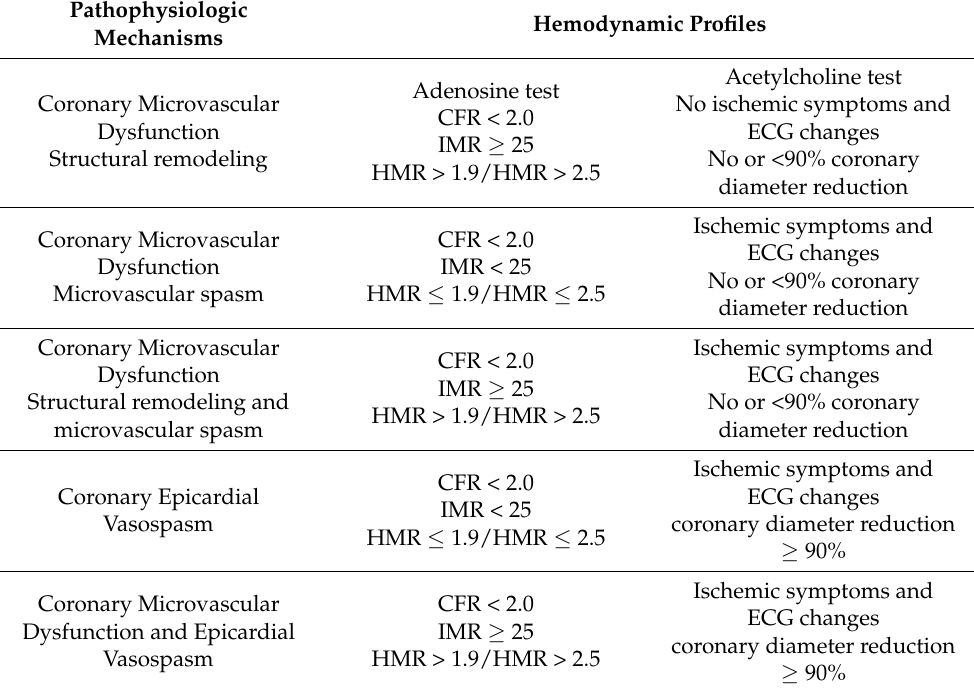
Table 1. Pathophysiological mechanisms and hemodynamic profiles of coronary microvascular dysfunction